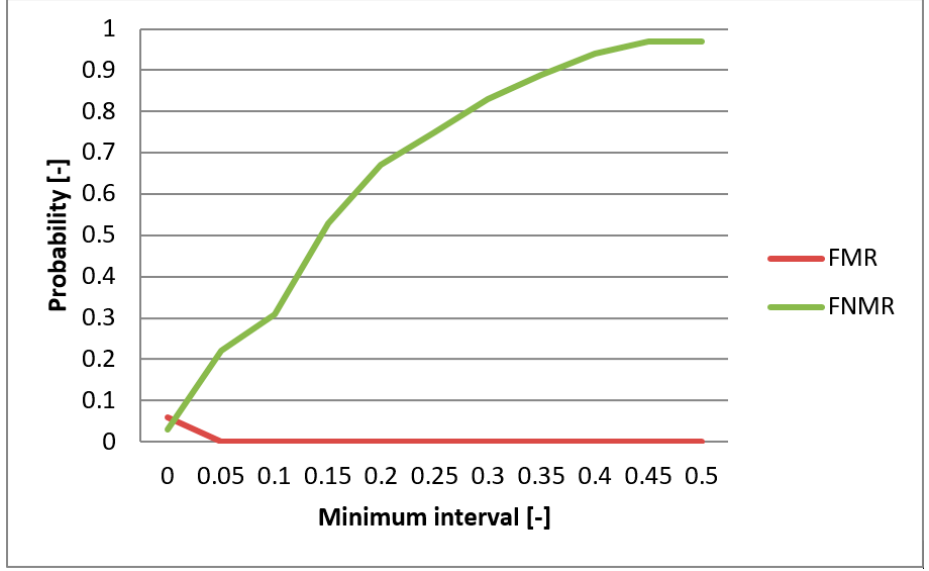
Figure 13. EER for united metrics of Hamming and MHV.